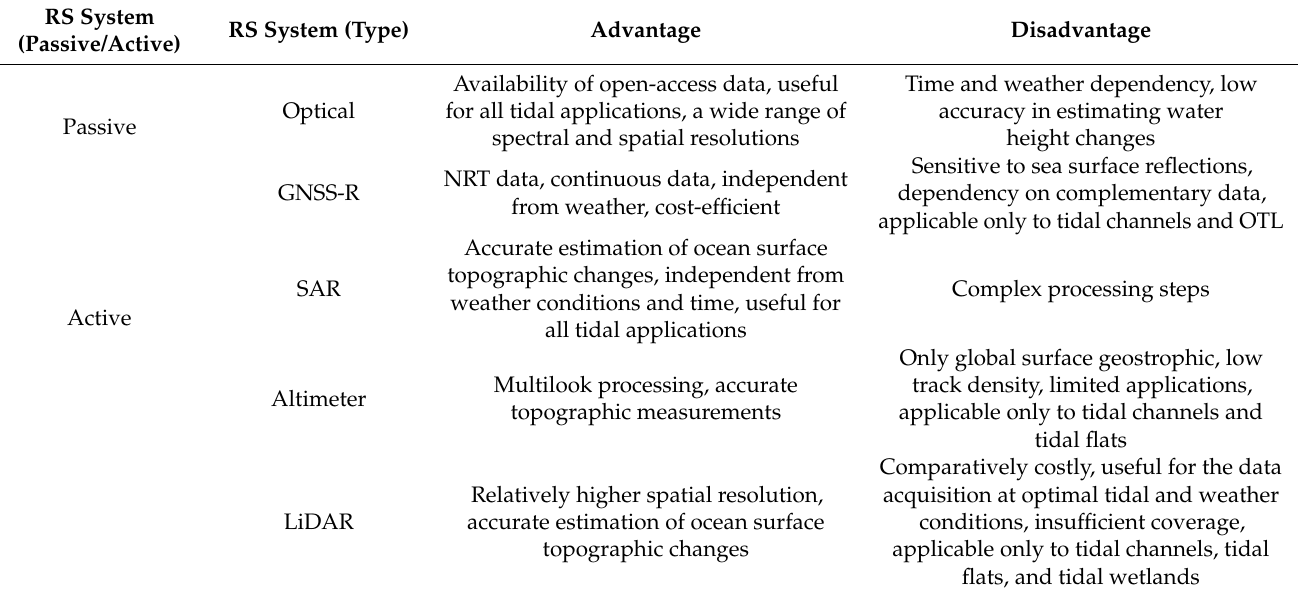
Table 5. Different RS systems for OT studies along with their advantages and